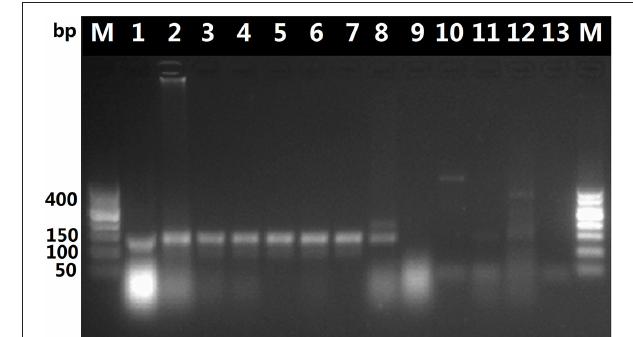
FIGURE 3 | Results of PCR with primers DCF4/DCR4 with DNA isolated from decoction and adulterants. Lane 1, pure O. sinensis DNA ( ∼ 120 ng); lanes 2, 3, and 4, amplification products from DNA ( ∼ 30 ng) isolated from O. sinensis decoction boiled for 60 min; lanes 5, 6, and 7, amplification products from DNA ( ∼ 30 ng) isolated from decoction boiled for 90 min; lanes 8, 9, 10, 11, and 12, results of PCR with pure DNA ( ∼ 30 ng) isolated from adulterants